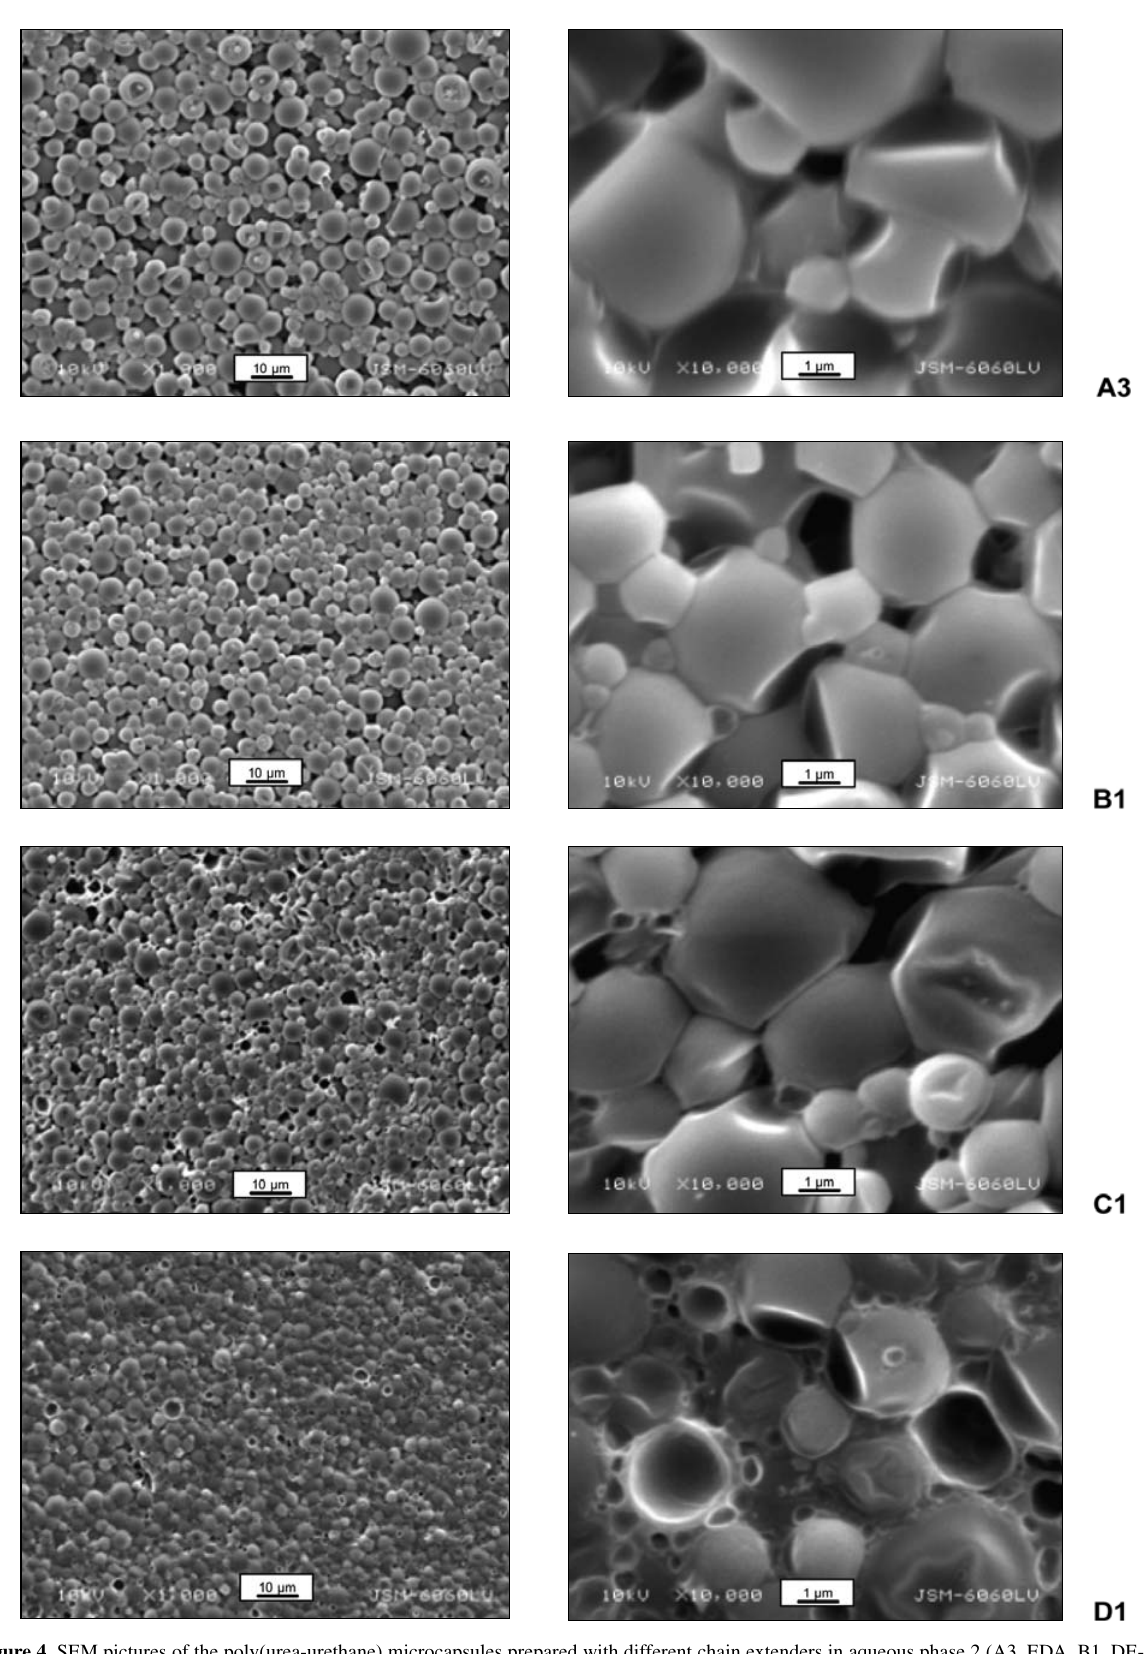
Pu{lar et al.: Using Chain Extenders to Modify Release Rates ...